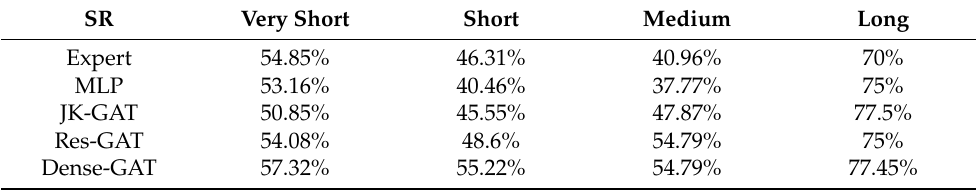
Figure 12. Distribution of road length in Maine. Table 4. Selection rate of each length group for different